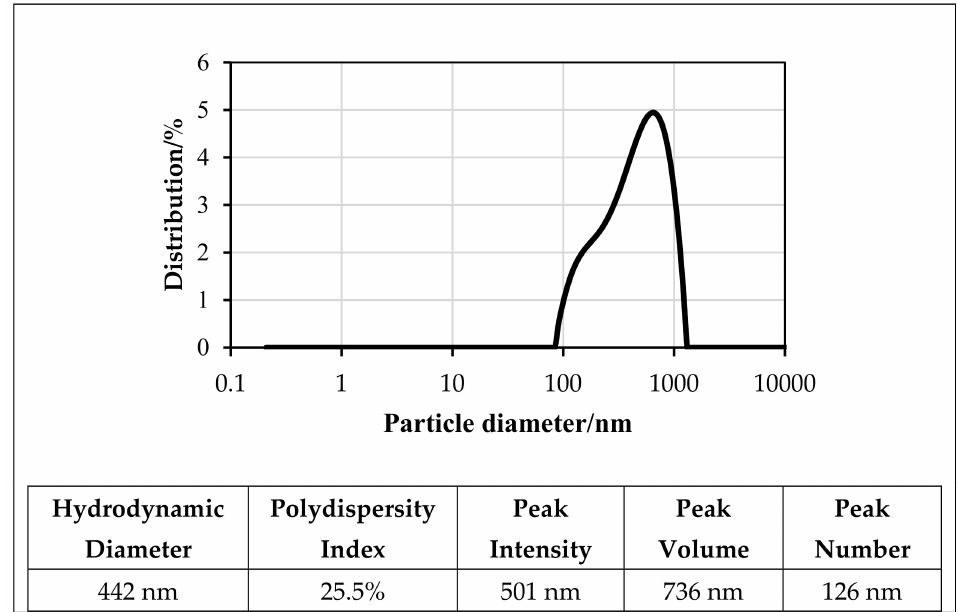
Figure 7. Particle size distributions for the f-GNPs nanofluid at 25 ◦